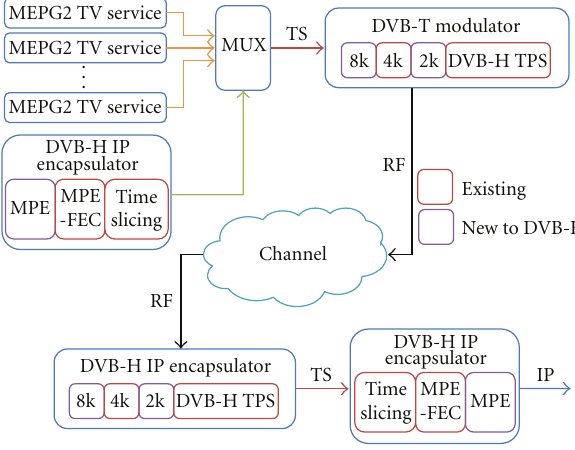
Figure 1: DVB-H Mobile TV Workflow. Figure 2: DVB-H/T System